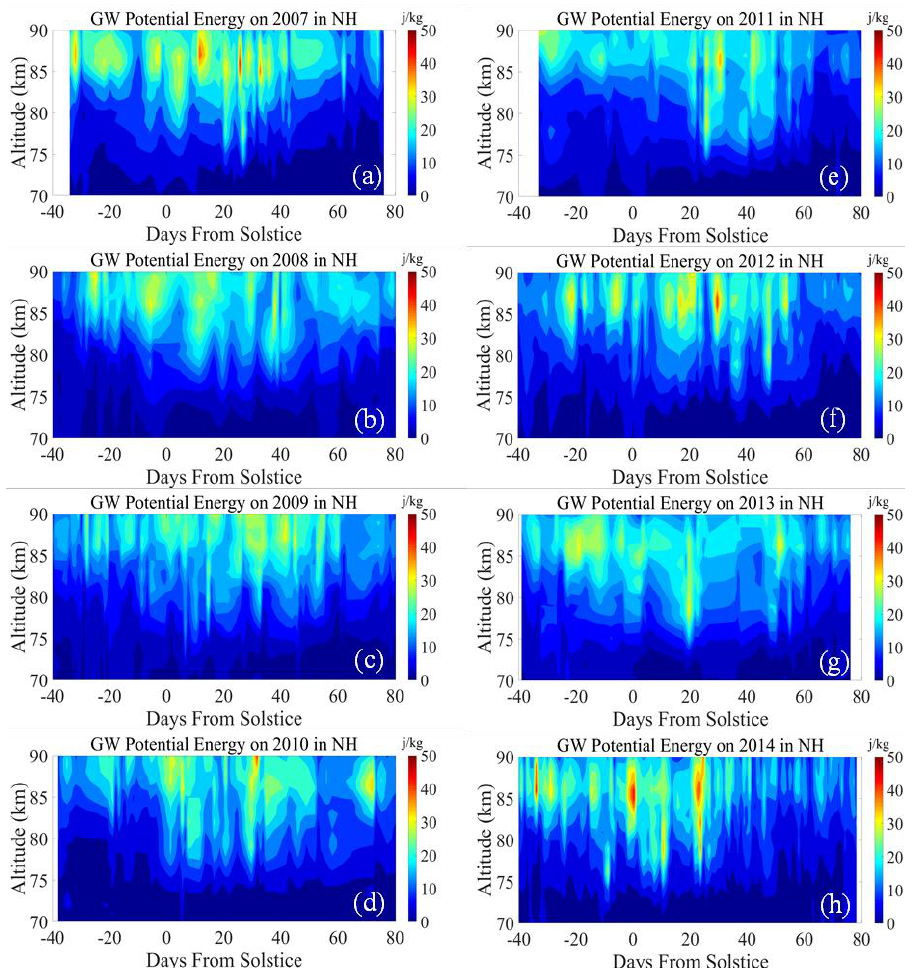
Figure 1. The GW potential energy distribution in the NH PMC seasons from 2007 to 2014. (a) GW potential energy on 2007 PMC season; (b) GW potential energy on 2008 PMC season; (c) GW potential energy on 2009 PMC season; (d) GW potential energy on 2010 PMC season; (e) GW potential energy on 2011 PMC season; (f) GW potential energy on 2012 PMC season; (g) GW potential energy on 2013 PMC season; (h) GW potential energy on 2014 PMC season.